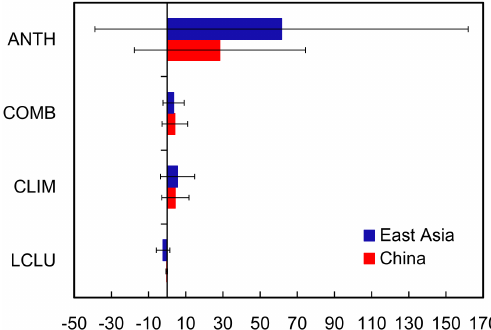
Figure 6. Estimates of ozone-related respiratory mortality (in 1000deathsyear − 1 ) attributable to historical (1980–2010) changes in land cover and land use (LCLU), climate (CLIM), climate and LCLU combined (COMB), and anthropogenic emissions (ANTH) in all of East Asia and China. Uncertainty for each case represents the 95% confidence interval of the concentration-response